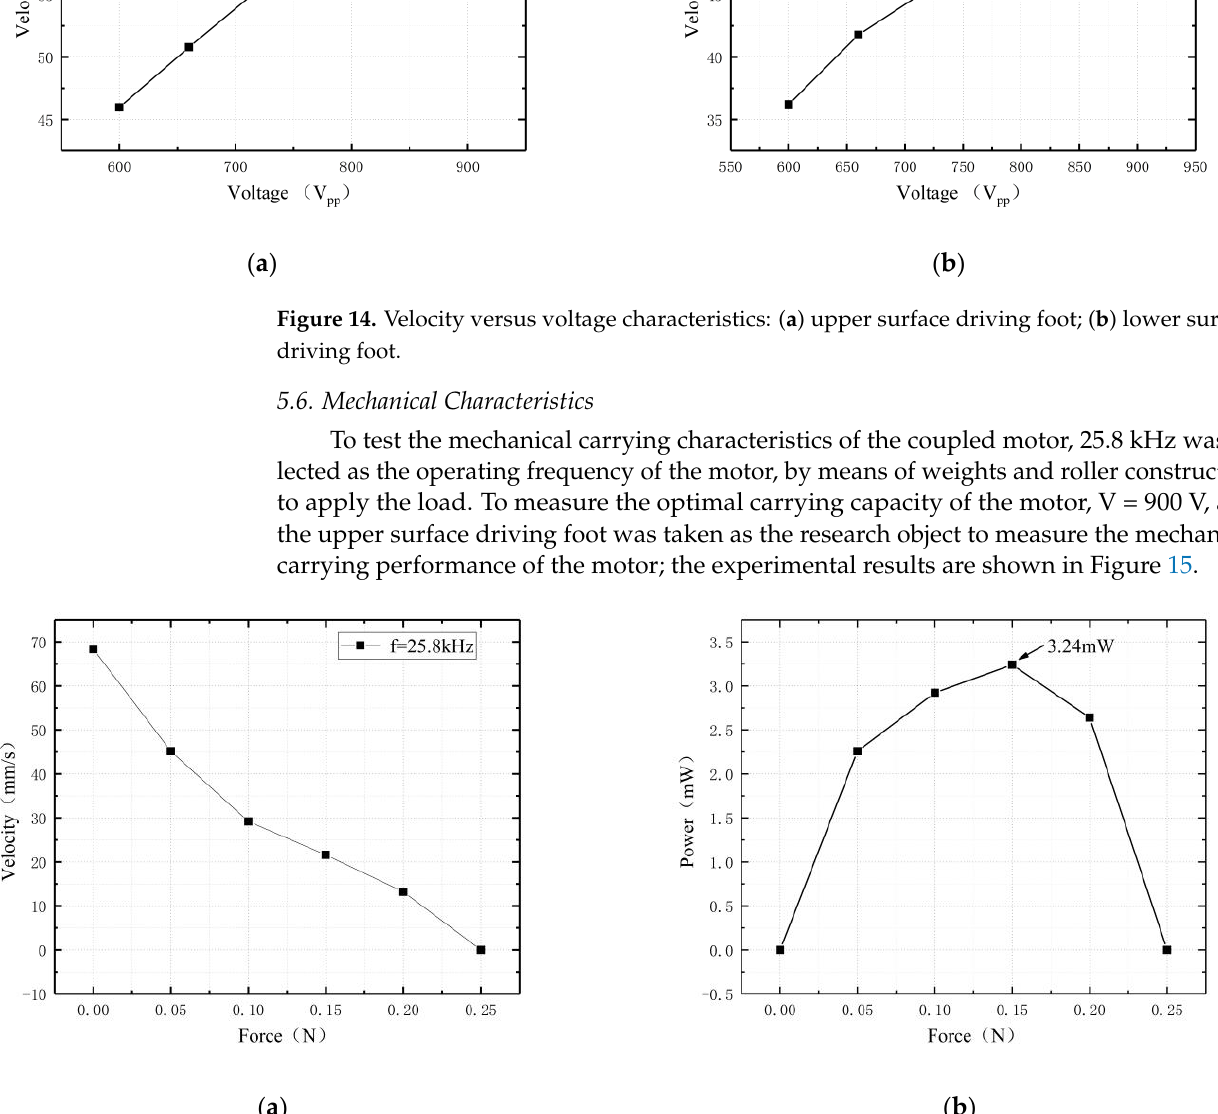
Figure 14. Velocity versus voltage characteristics: ( a ) upper surface driving foot; ( b ) lower surface driving foot.